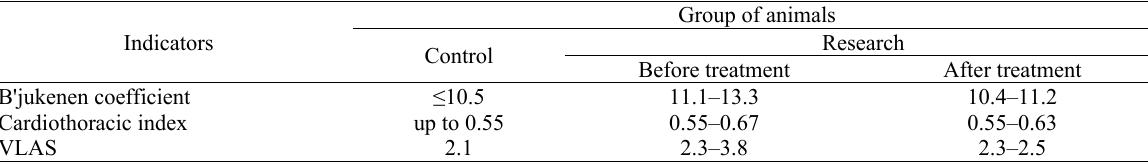
Radiographic parameters in dogs with the development of heart failure and the action of the drug “Bendamine” (M ± m; n = 10)